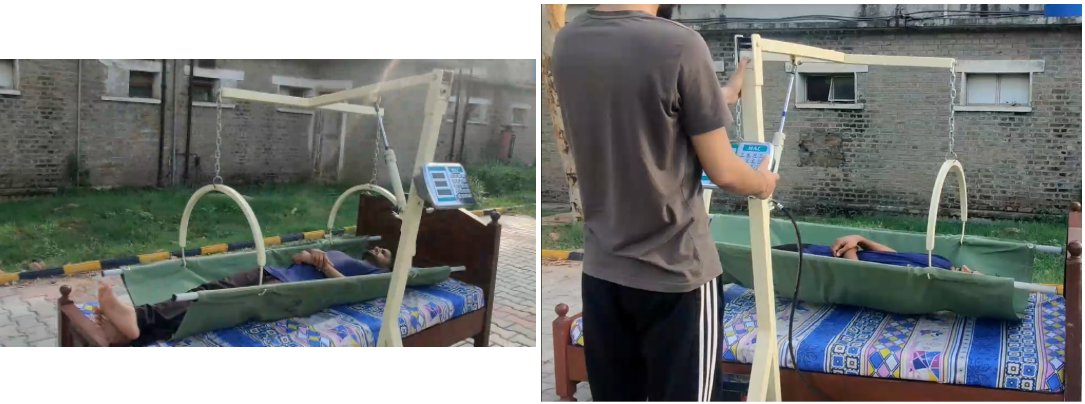
Figure 15. Weight measuring using the designed device.